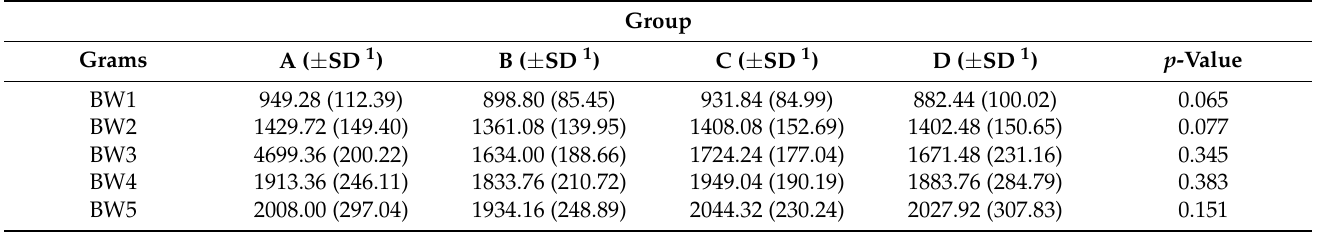
Table 2. Descriptive statistics for body weights of female mink (mean and standard deviation) for the whole experimental period ( n = 25 per group).